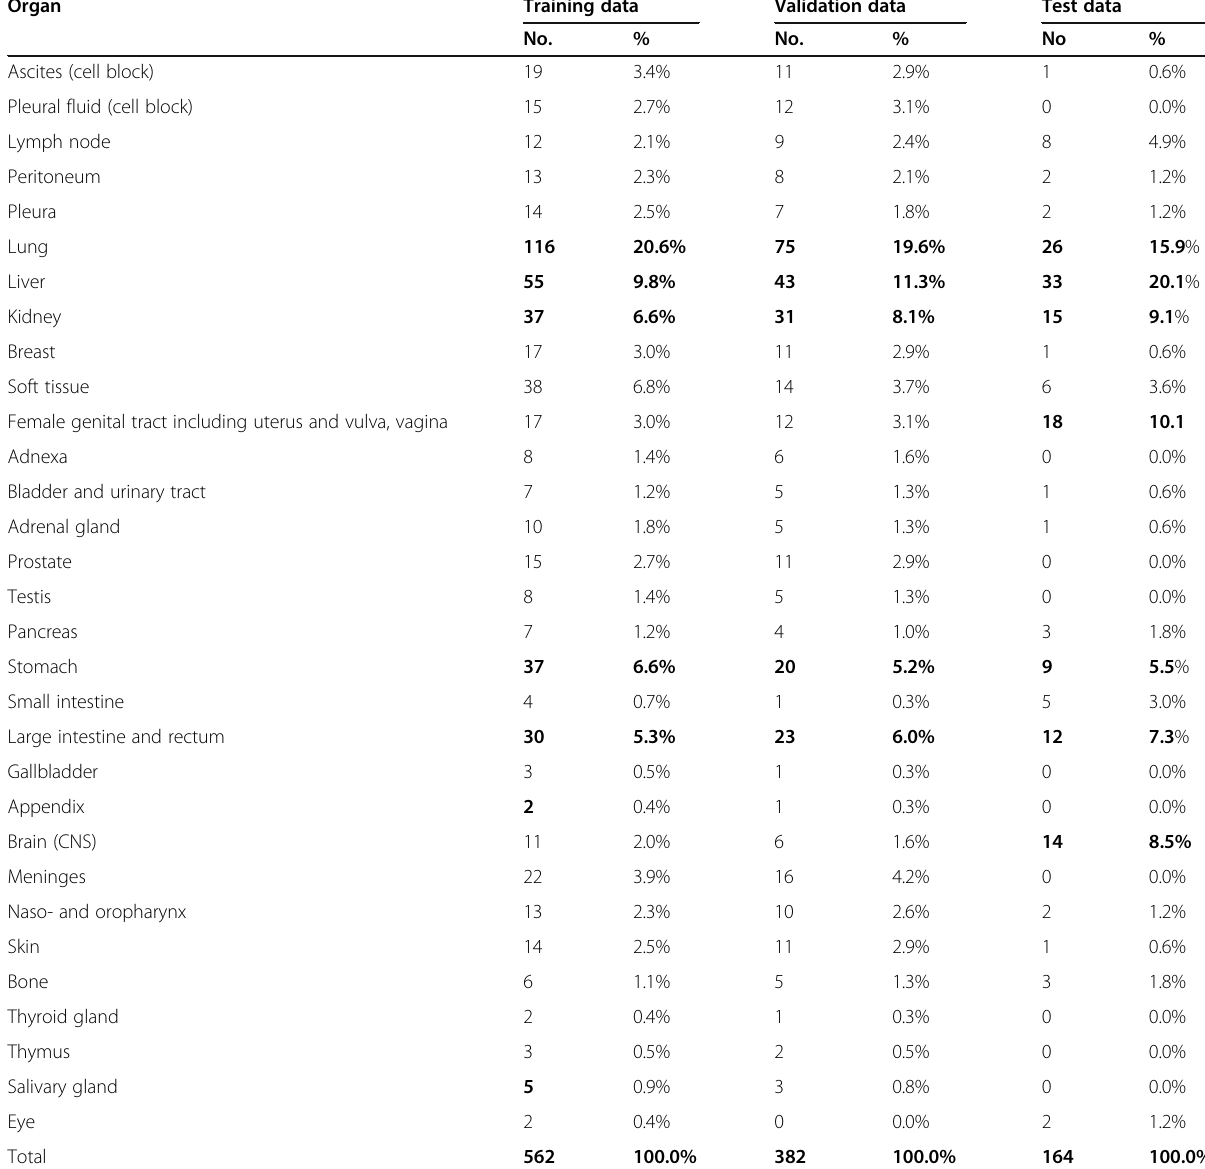
Table 1 The organs of the training and validation dataset of TUO